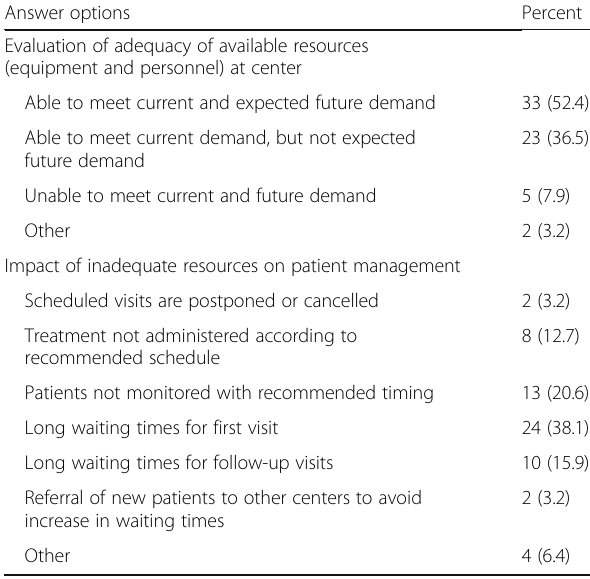
Table 4 Resources for patient management Answer